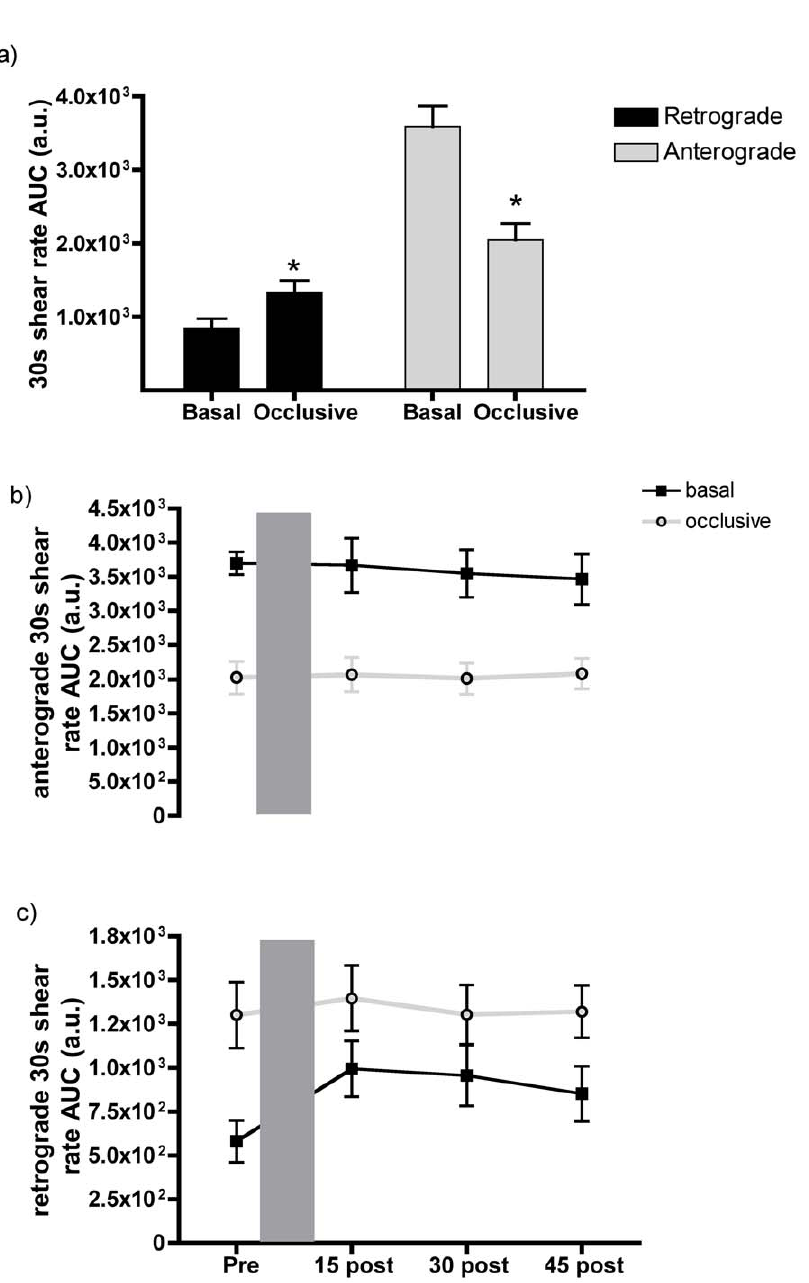
Figure 5. Basal and distal occlusive brachial anterograde and retrograde shear rates. a) An increase in retrograde and a concomitant decrease in anterograde shear rate were evident upon distal arterial occlusion. This graph illustrates the mean of all vascular function responses. b) Basal and occlusive anterograde AUC shear was not altered by the prolonged low flow (PLF) (PRE vs. POST15, 30 or 45). Similarly c) basal and occlusive retrograde AUC shear were not altered by the PLF. Since menstrual cycle phase had no impact, mean responses are illustrated in graphs a and b. * Indicates a significant difference ( p # 0.05) between basal and occlusive velocities. AUC is the area under the curve.